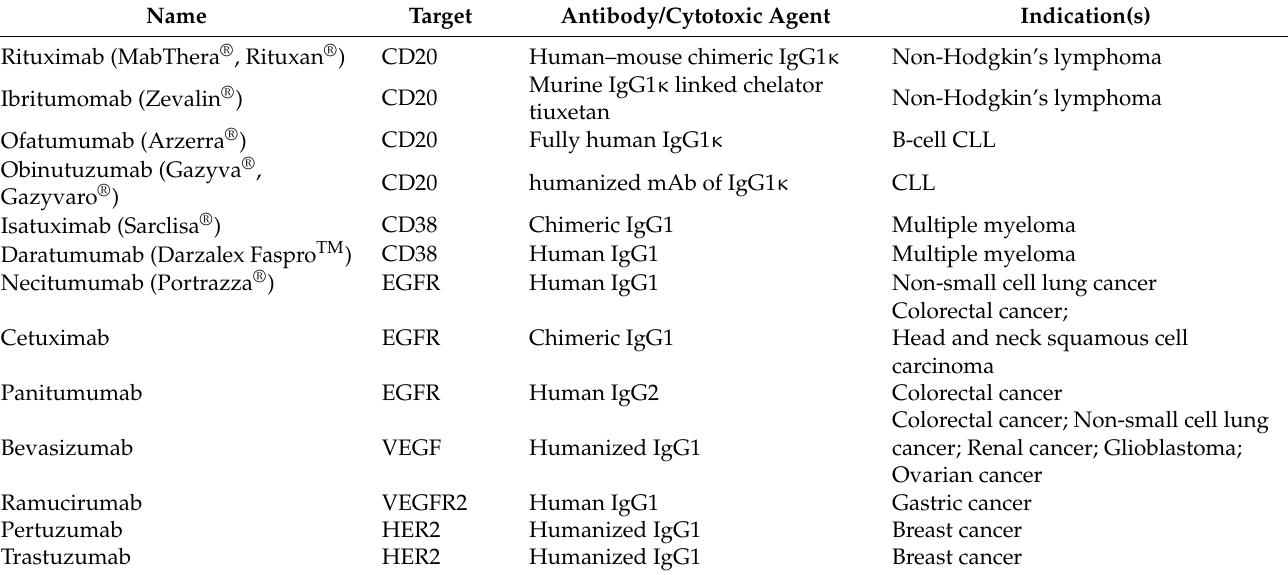
Table 2. Summary of monoclonal antibodies used in the treatment of cancer in the